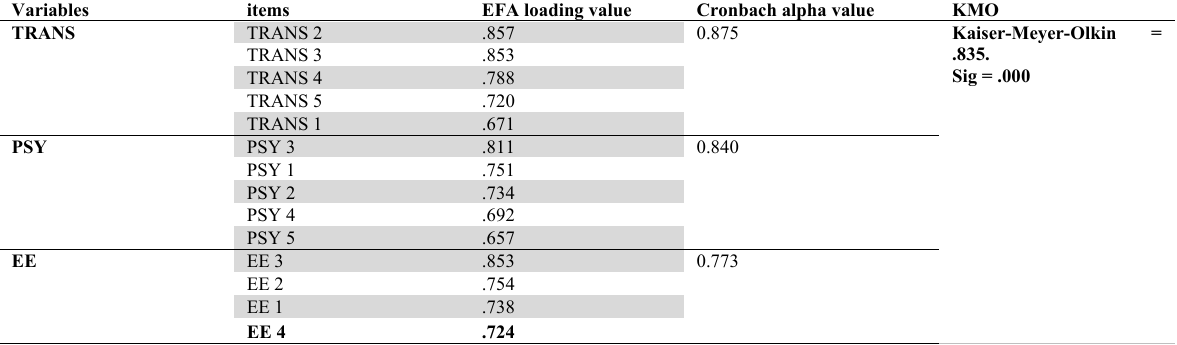
Reliability Test